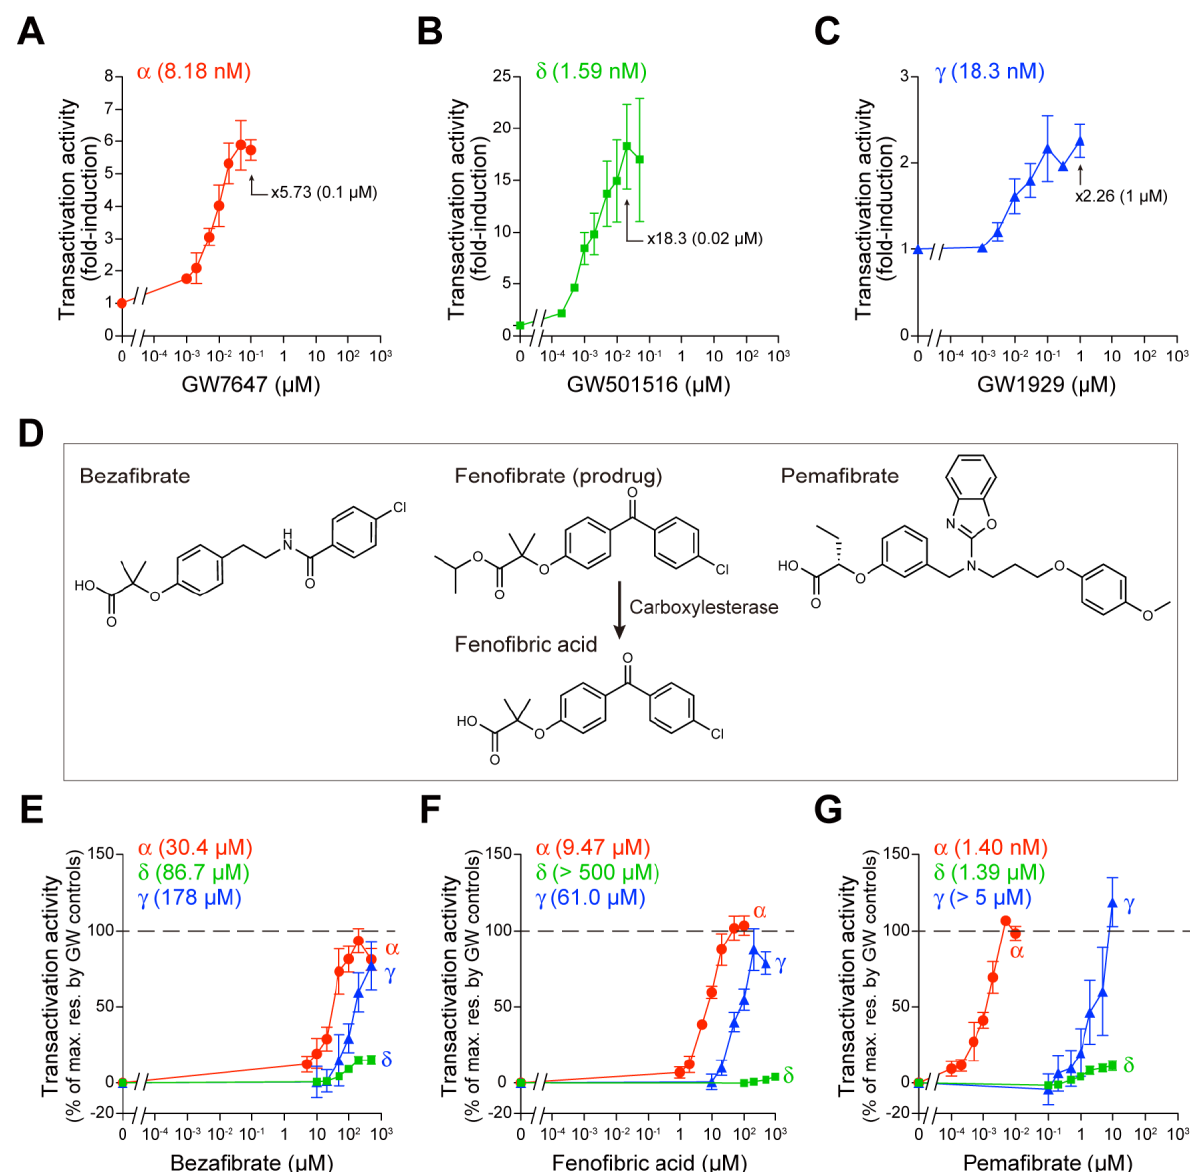
Figure 1. PPAR α / δ / γ -LBD-mediated transactivation assay in COS-7 cells. ( A – C ) Control experiments. Human PPAR α / δ / γ -LBD-mediated Firefly luciferase transactivation was induced by selective PPAR agonists: GW7647 for PPAR α ( A ), GW501516 for PPAR δ ( B ), and GW1929 for PPAR γ ( C ) in a concentration-dependent manner. The maximal responses were observed at 0.1 µM, 0.02 µM, and 1 µM, respectively, which are used as the 100% responses in ( E – G ). ( D ) Chemical structures of fibrates used in this study. Fenofibrate is a prodrug that is metabolized by tissue and plasma carboxylesterases [22] to its active form, fenofibric acid. ( E – G ) PPAR α / δ / γ -LBD-mediated trans- activation by bezafibrate ( E ), fenofibric acid ( F ), and pemafibrate ( G ). Data are means ± standard error (SE) of three independent experiments with duplicate samples, and calculated EC 50 values are